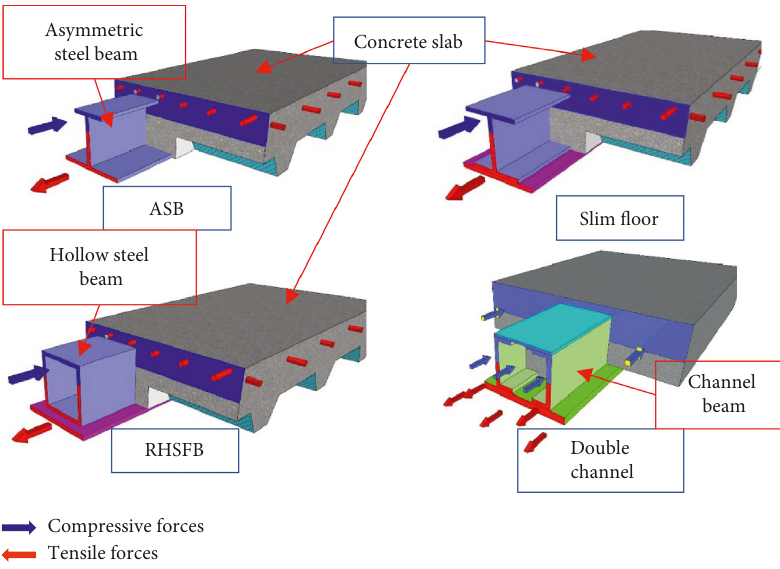
Figure 3: Different types of integrated steel beam in composite slim